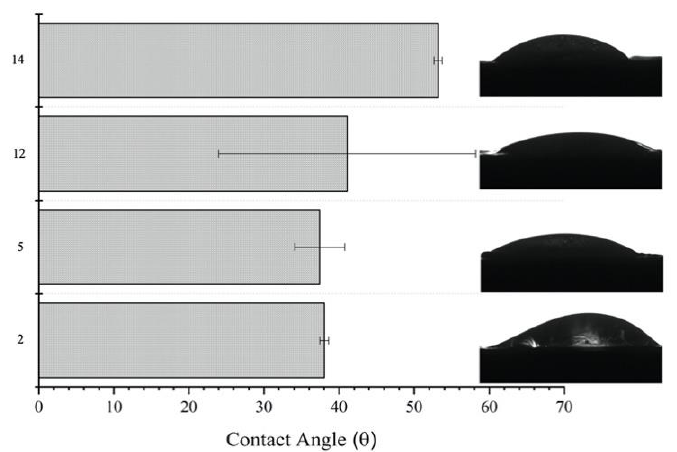
Figure 3. Contact angle values (Mean ± SD) and images from the conditions of experimental design resulting in the obtention of samples 2, 5, 12, and 14.